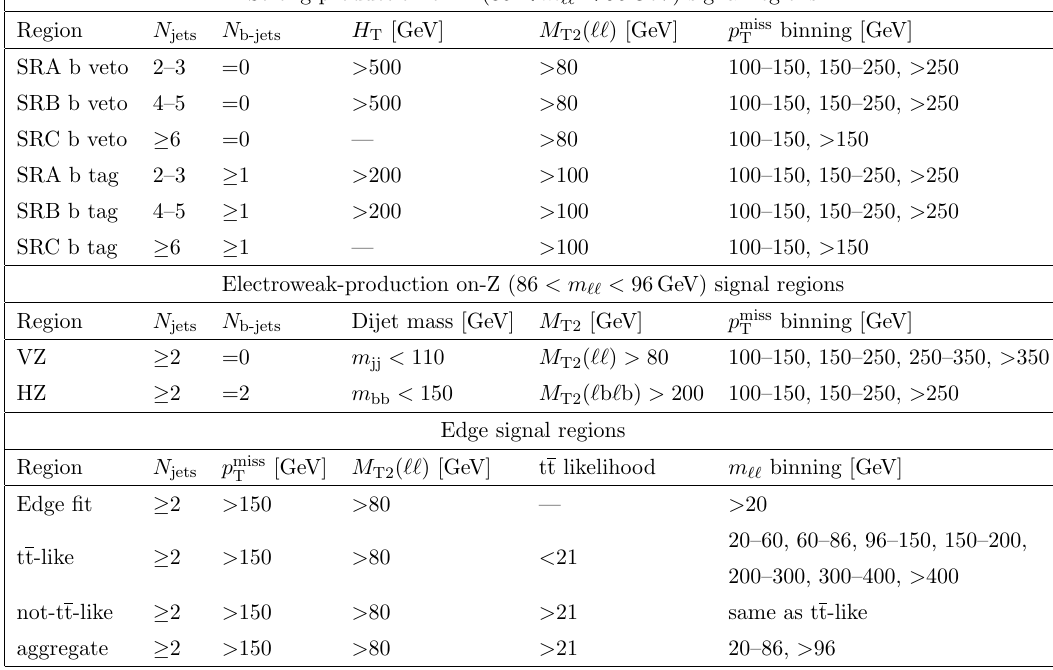
Table 1 . Summary of all SR